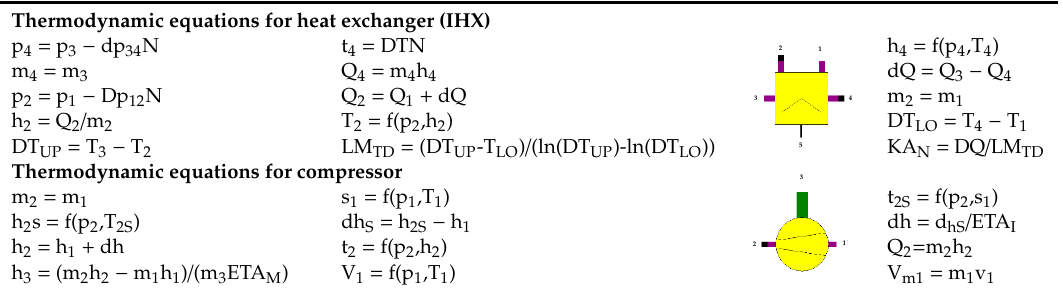
Table 3. General model formulations.